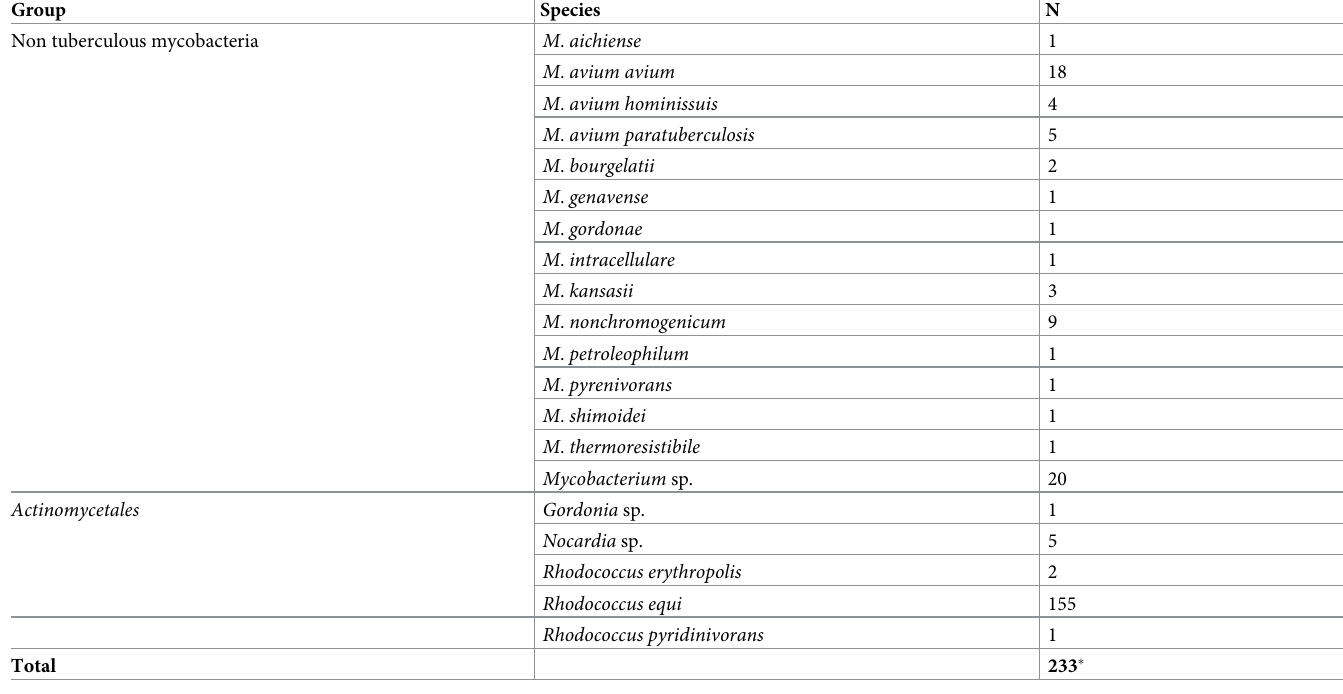
Table 3. Bacteria identified by hsp65 and rpoB sequencing from DNA extracted from lymph nodes with bTB-like lesions. Group